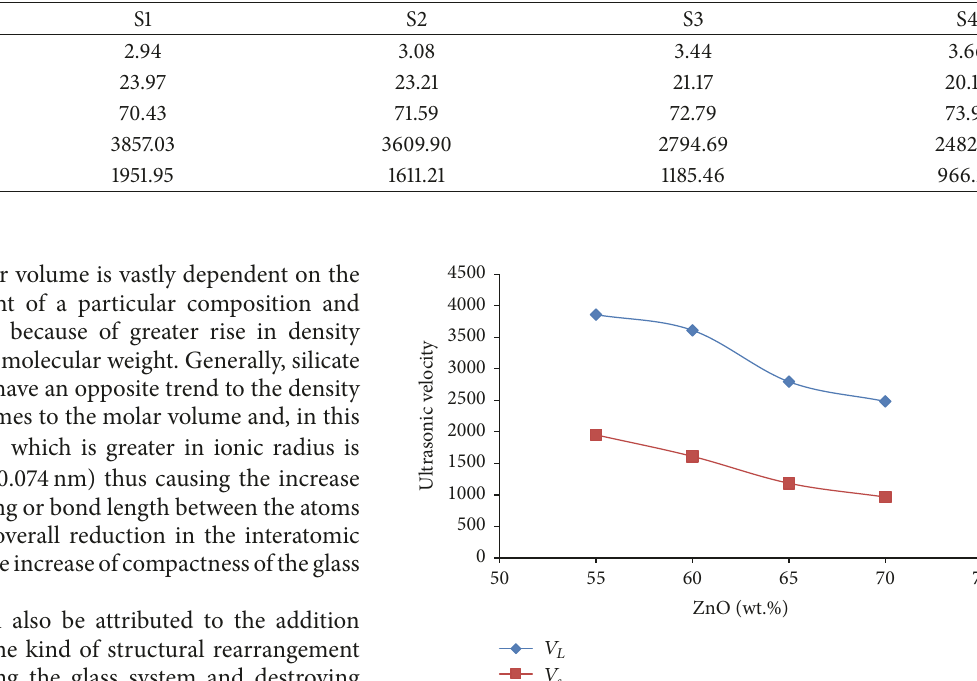
Table 3: Density, molar volume, molecular weight, and ultrasonic velocity of ZnO–SiO 2 samples.